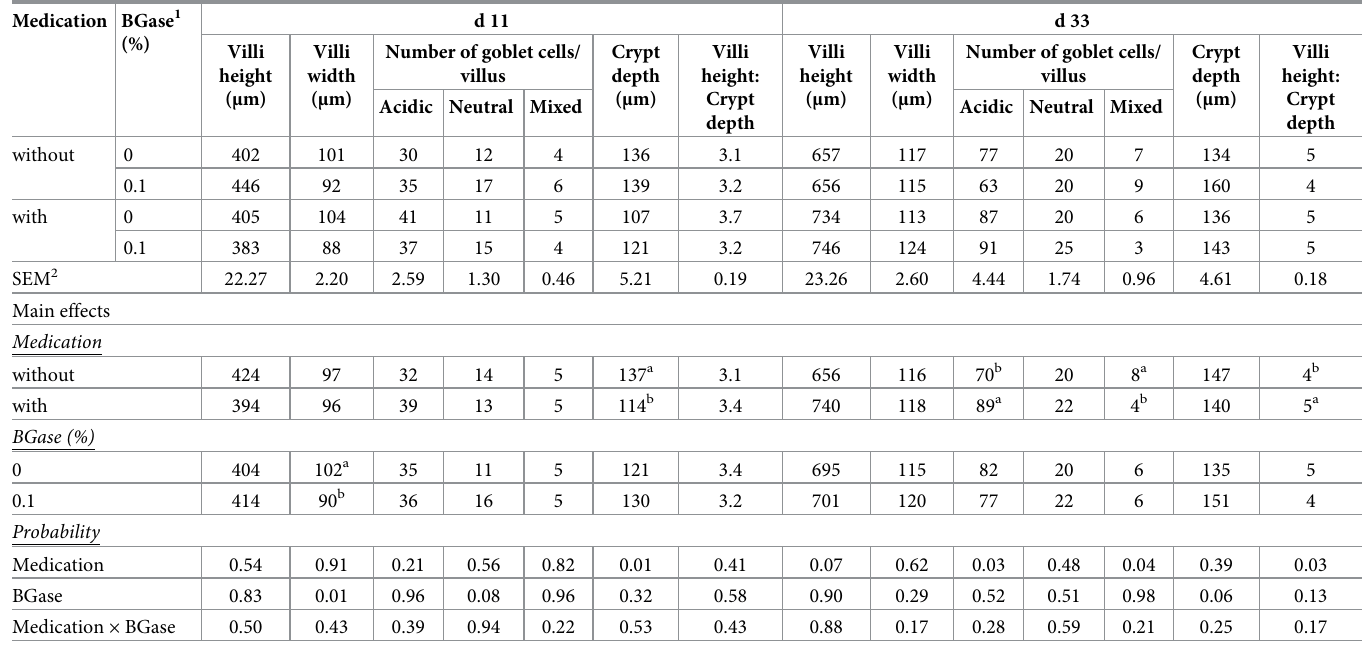
Table 15. Effects of medication and β -glucanase on histomorphology responses in the ileum of broiler chickens (Experiment 2). Medication BGase 1